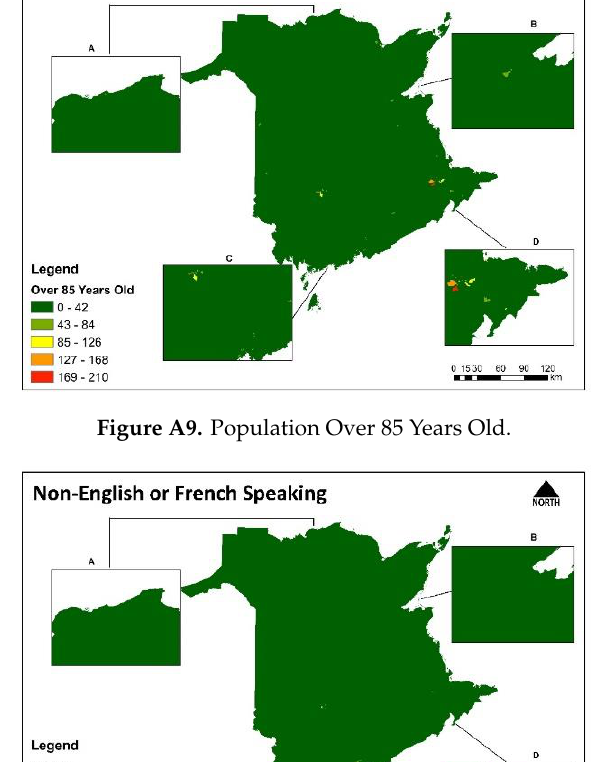
Figure A8. Lone Parents.